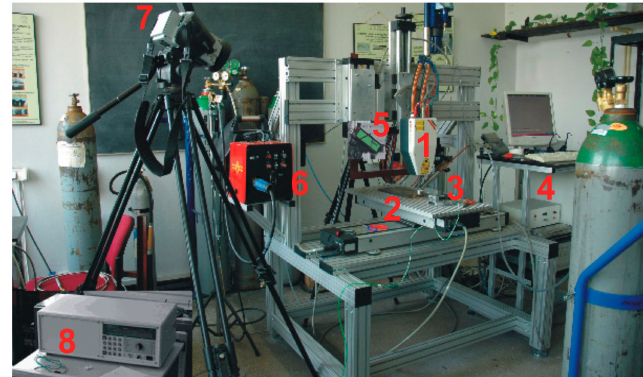
Figure 1. A view of experimental setup equipped with the high power direct diode laser (HPDDL) ROFIN SINAR DL020 ( 1 ), positioning system ( 2 ), mounting device ( 3 ), computer control system ( 4 ), pyrometer IMPAC IS 140 ( 5 ), electronic controller ( 6 ), infrared camera ThermaCAM P640 ( 7 ), and multichannel numerical recorder Agilent 34970A ( 8